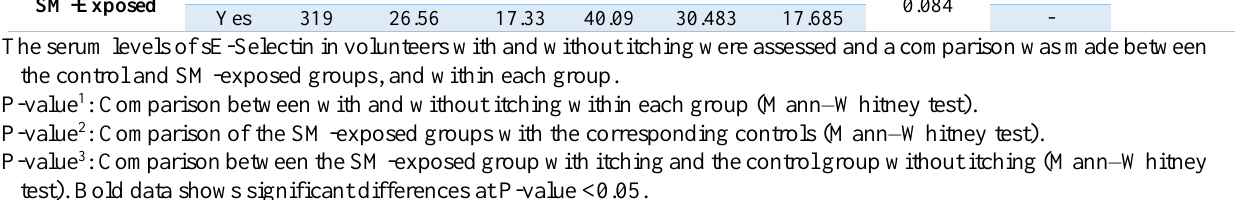
Table 6 . sL-Selectin in Control and Sulfur Mustard Exposed Groups With Itching SL-Selectin(pg/mL) Study Groups Itching Median Q1 Q3 Mean SD No 45 Control